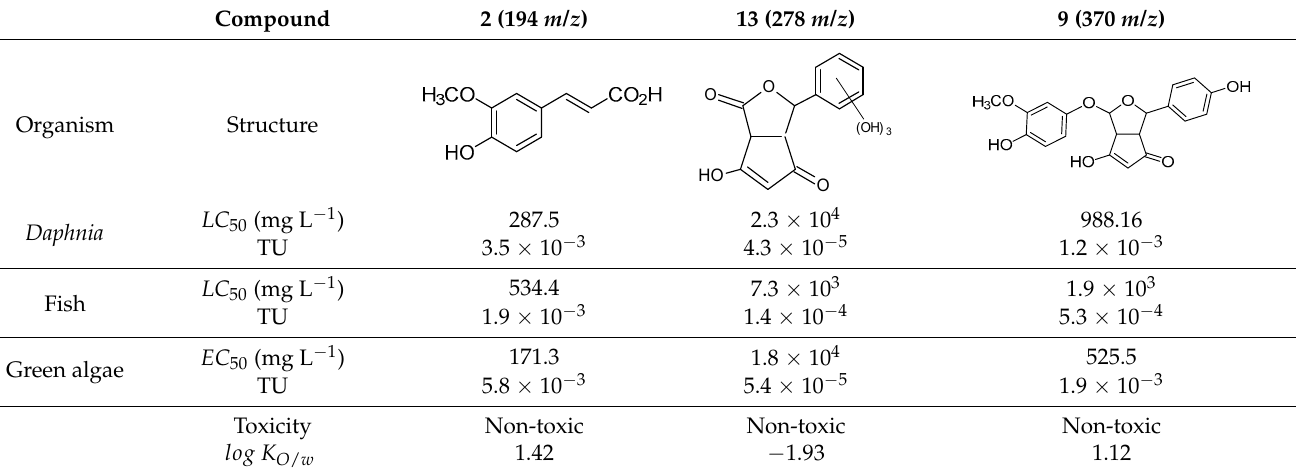
Table 2. Predicted acute toxicity to Daphnia , fish, and green algae for some intermediates of cur- cumin photodegradation: LC 50 , EC 50 , log K O / w , water-solubility, acute toxic unit (TU), and toxicity classification. Compound 2 (194 m/z )